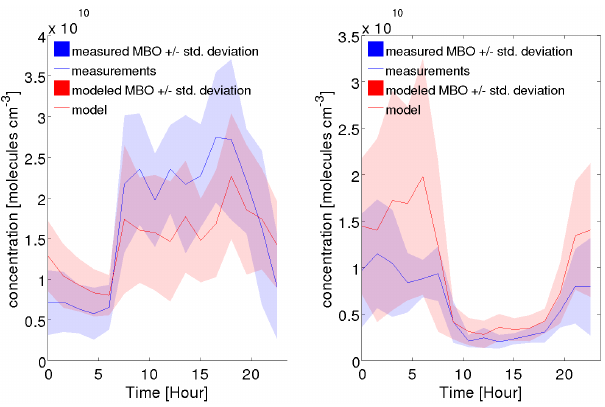
(left) and monoterpene (MT, right) concentrations. Measurement average (line) and ± 1 standard deviation (shaded area) are in blue; model average (line) and ± 1 standard deviation (shaded area) are in red. The comparison is made at